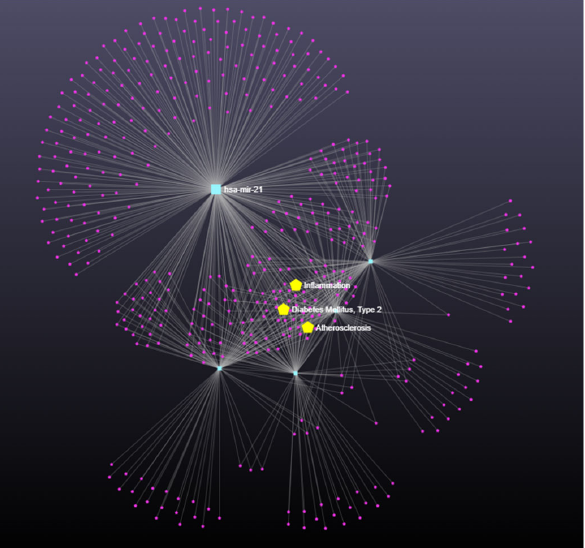
Figure 3. miRNet analysis (miRNet) showed that miR ‐ 9, miR ‐ 21, miR29 ‐ b, miR ‐ 122, and miR ‐ 132 are interconnected and involved in inflammation, type 2 diabetes mellitus, and atherosclerosis. Evaluating the relationship between miRNAs with inflammatory molecules in AD, we found that miR ‐ 122 significantly correlated with plasma levels of GM ‐ CSF, INF ‐α 2, IL ‐ 1 α , IL ‐ 8, and MIP ‐ 1 β (Table 2). Table 2. Partial correlation between cytokines and miR ‐ 122 in AD controlled by gender (n = 40). Partial Correlations Correlation Coefficient (r) p ‐ Value miR ‐ 122/GM ‐ CSF 0.389